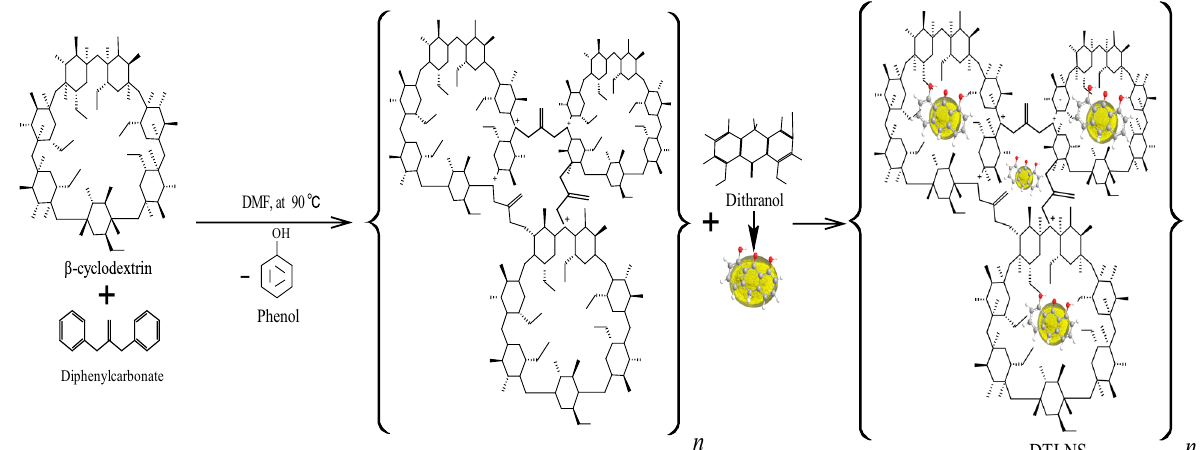
Fig. 1 Schematic representation of synthesis and interaction between dithranol and β-cyclodextrin-based